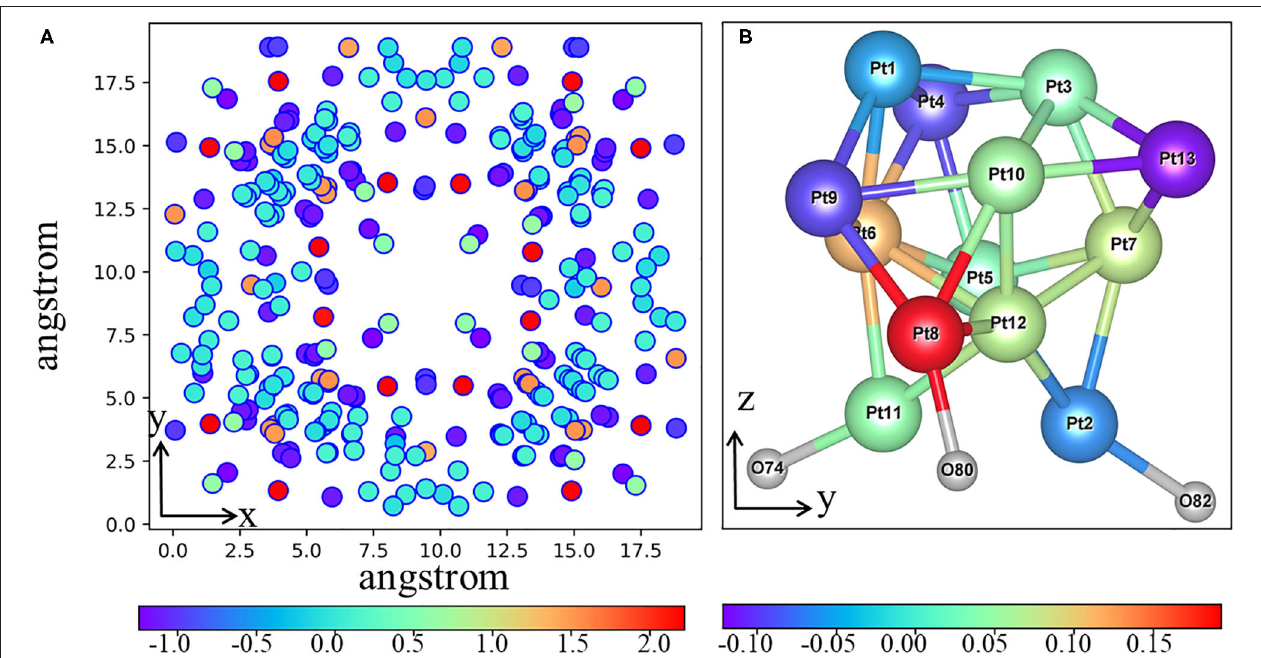
FIGURE 6 | (A) The cluster model from the crystal for the TDDFT study, (B) the highest occupied molecular orbital (HOMO) of the cluster model, and (C) the lowest unoccupied molecular orbital (LUMO) of the cluster model.